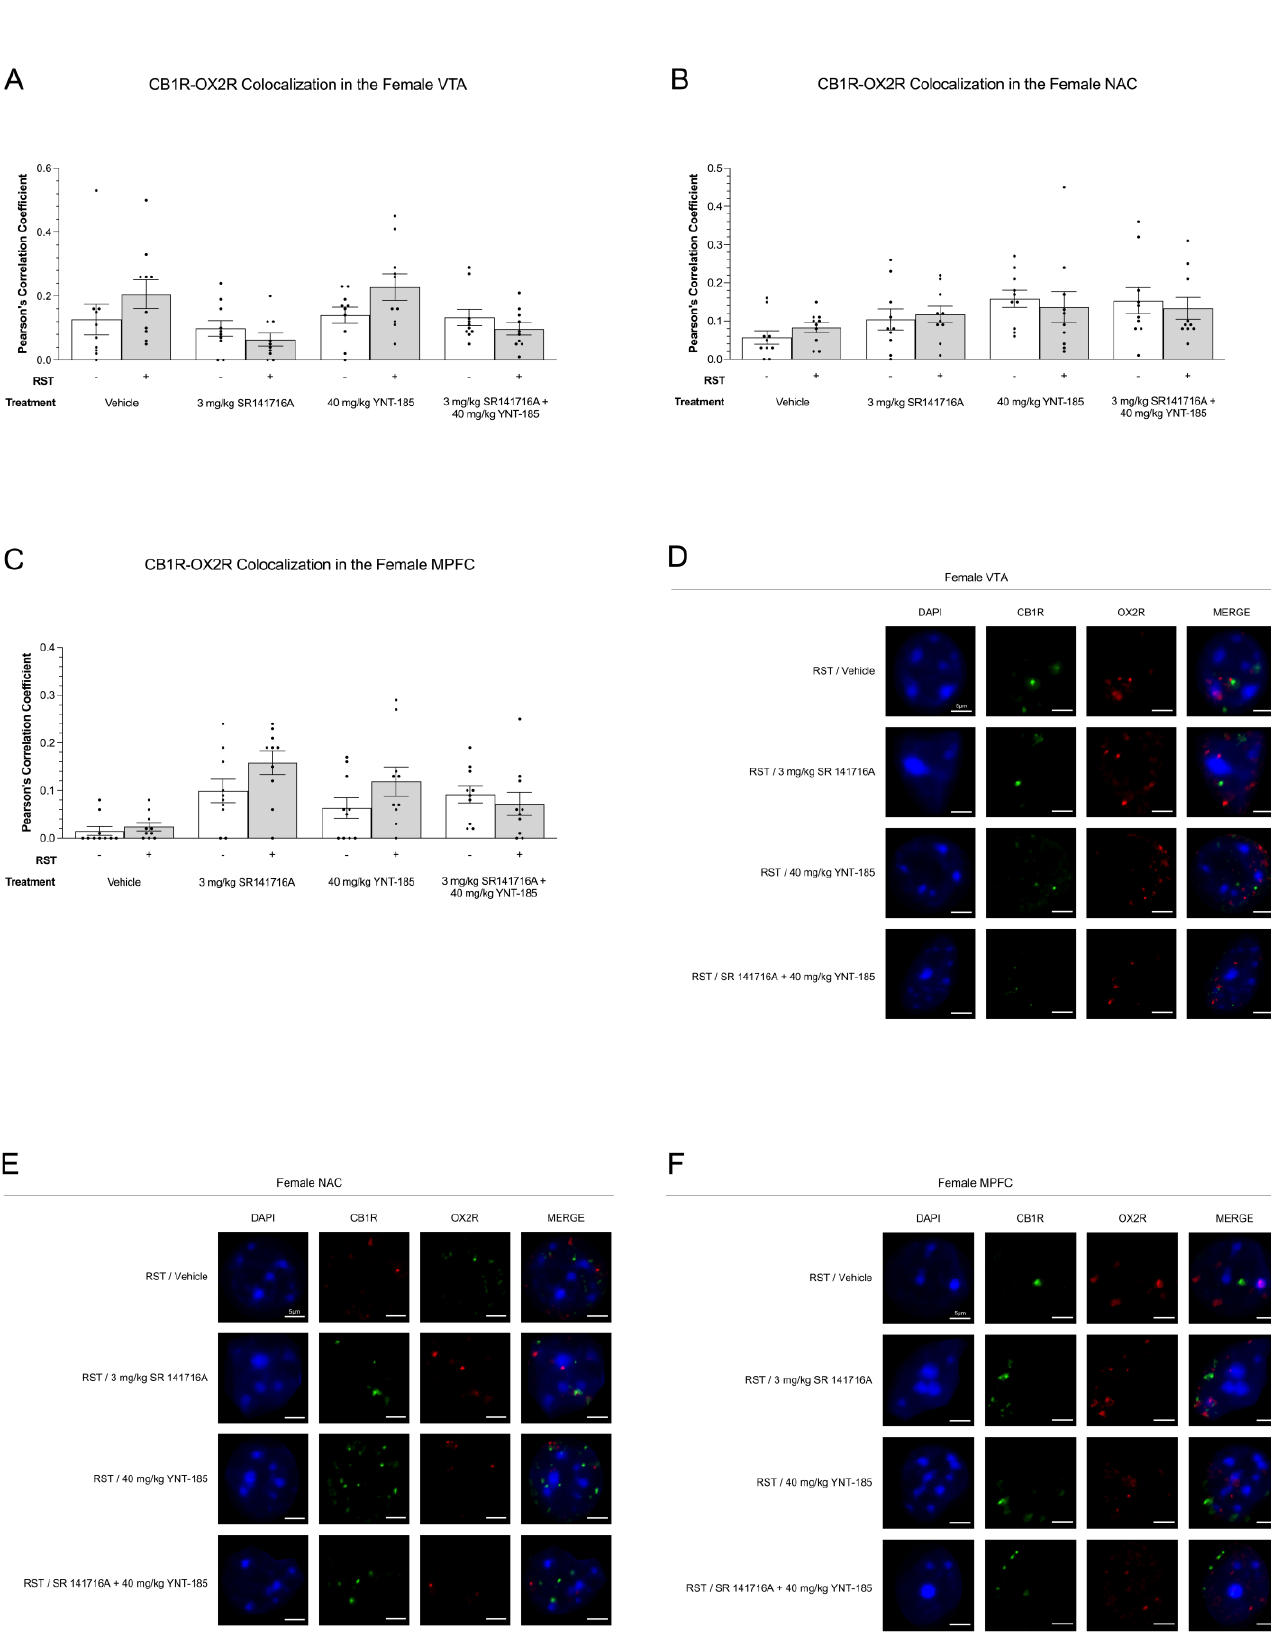
Figure 8. Cannabinoid receptor type 1 and OX2R colocalization throughout mesocorticolimbic brain regions of female mice subjected to 24 h RST and cannabinoid and orexin drug treatments. ( A – C ), CB1R-OX2R colocalization in the VTA ( A , D ), NAC ( B , E ), and MPFC ( C , F ) of 200 µL vehicle, 3 mg/kg